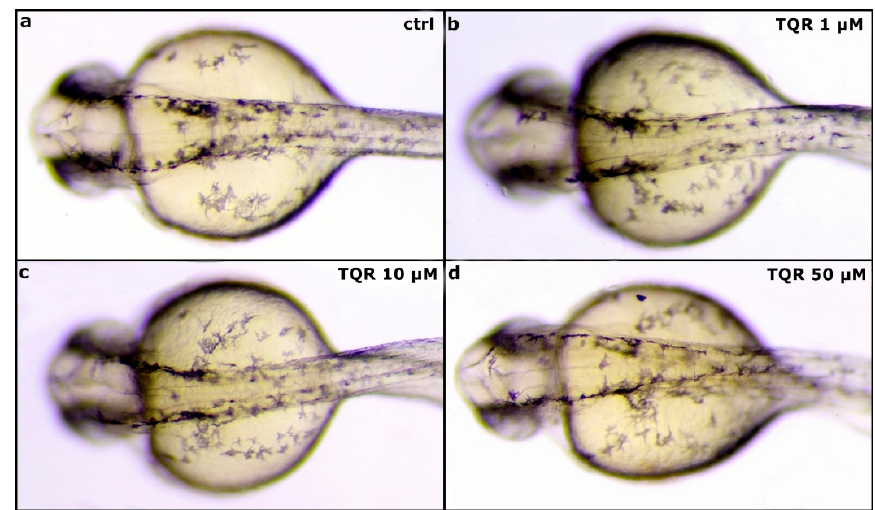
Figure 1. Zebrafish melanophore pigmentation following the exposure to tariquidar (TQR) at 30 hours post fertilization (hpf). A set of photographs presenting a dorsal view of 30 hpf zebrafish embryo displaying effects of tariquidar (TQR) exposure on the melanophore pigmentation within the dorsal head in four experimental groups: ( a ) control, ( b ) exposed to TQR 1 µM, ( c ) exposed to TQR 10 µM, and ( d ) exposed to TQR 50 µM. The developing dark pigment pattern does not show visible differences between the groups.